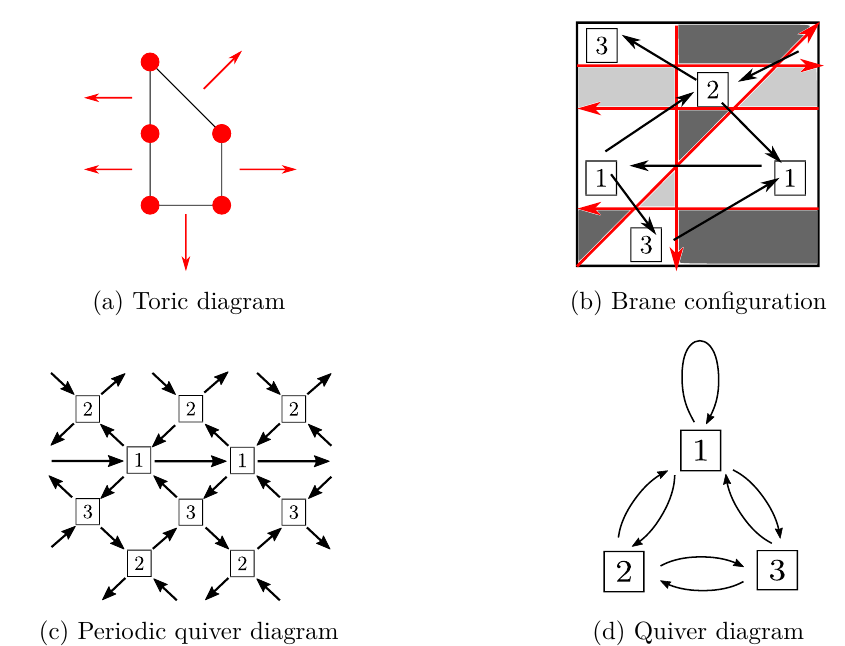
Figure 43. Toric diagram, brane configuration, periodic quiver, and quiver diagram for the Suspended Pinch Point (SPP) singularity. (a) Toric diagram for the SPP. (b) The rectangle is a fundamental domain of the torus T 2 , and the boundary is identified periodically. The red lines divides the fundamental domain into several domains, and the white regions are assigned vertices of (c) and (d). (c) Periodic quiver diagram obtained by extracting vertices and arrows from the brane configuration. (d) Quiver diagram obtained from the brane